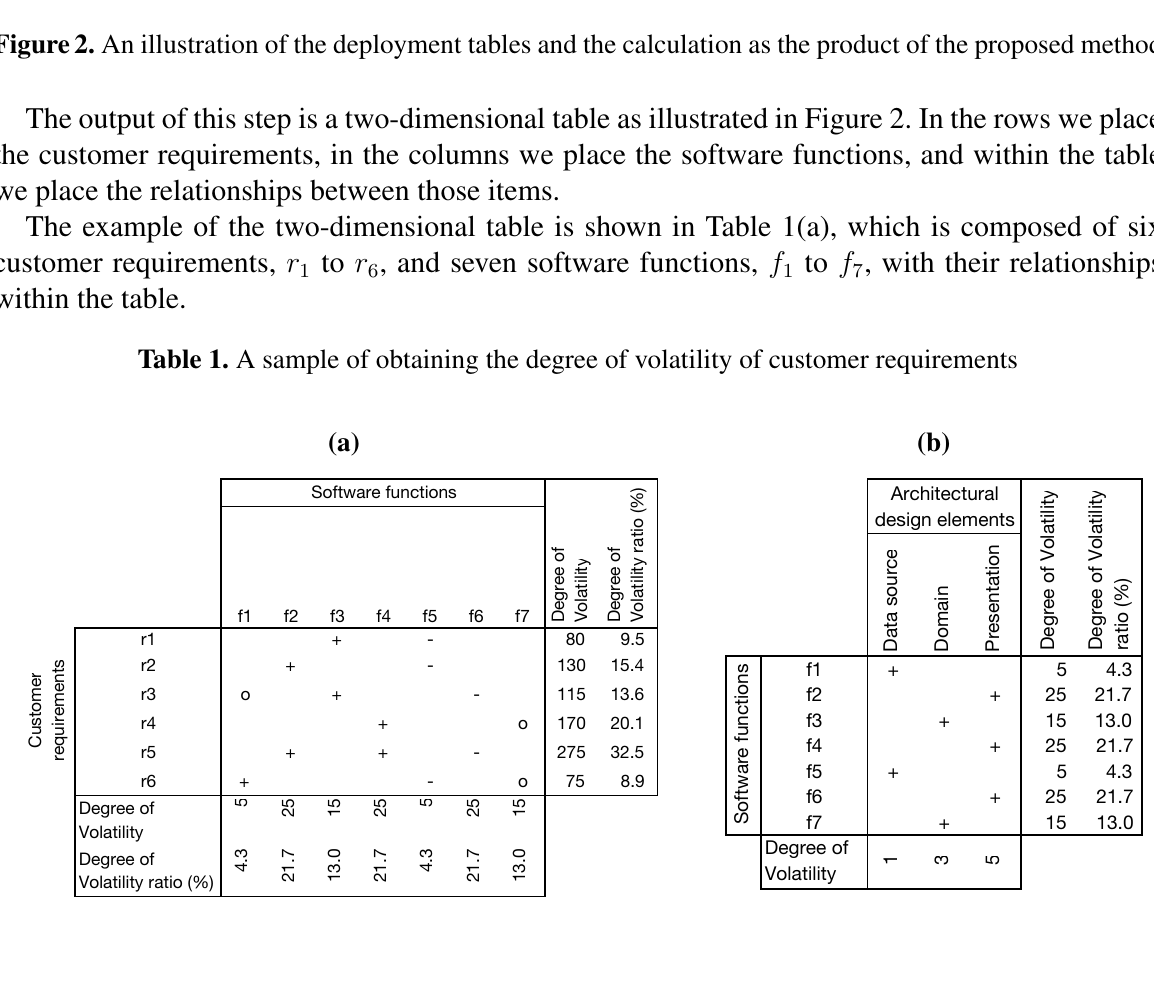
Figure 2. An illustration of the deployment tables and the calculation as the product of the proposed method